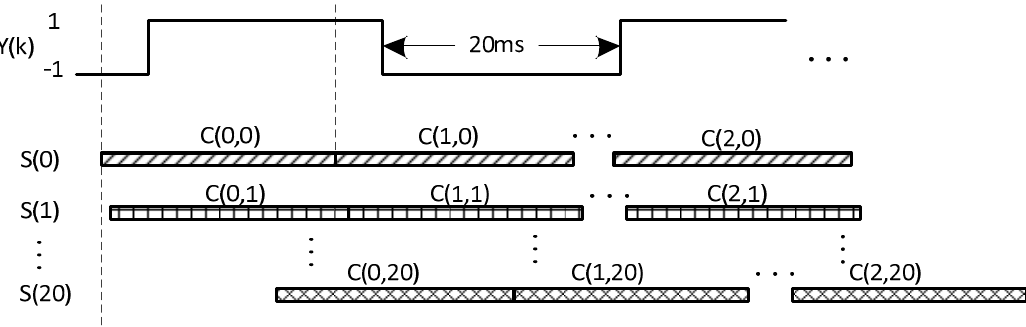
Figure 2. Diagram of the ML bit synchronization method.